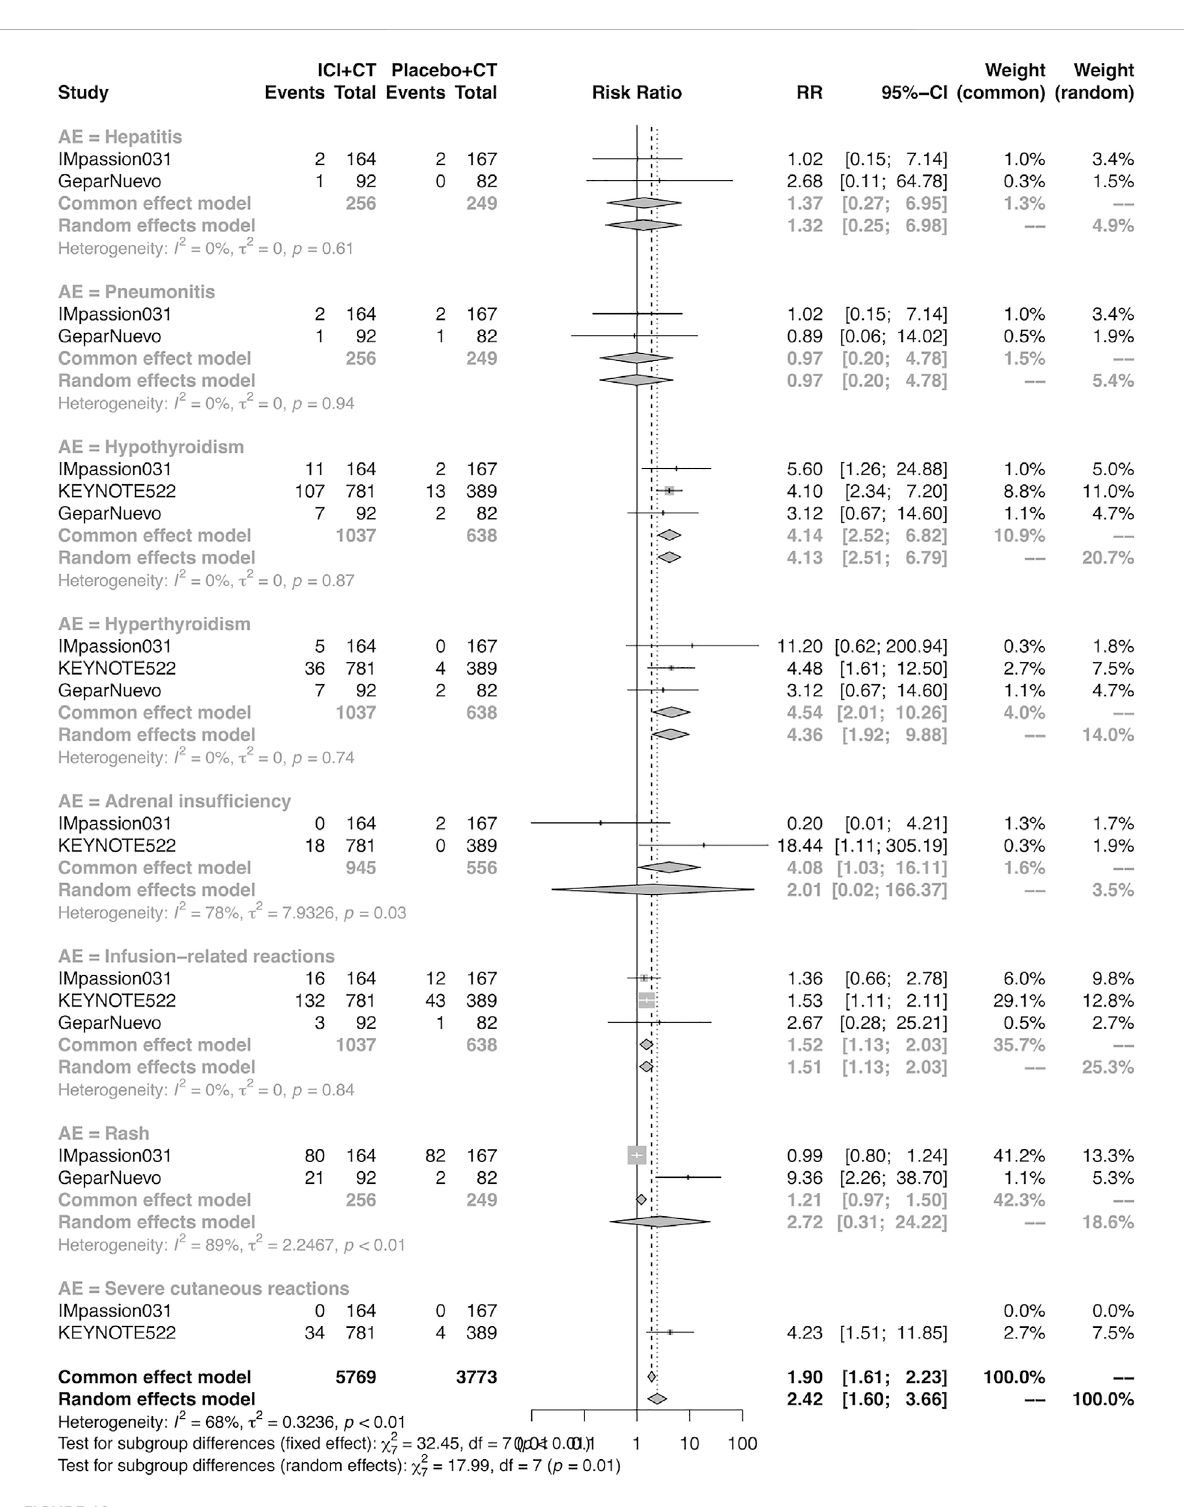
FIGURE 12 Pooledspeci fi cAEsinanygradeinneoadjuvanttherapyclinicaltrials.AEs,adverseevents;RR,relativerisk;95%CI,95%con fi denceinterval;ICIs, immune checkpoint inhibitors; CT,